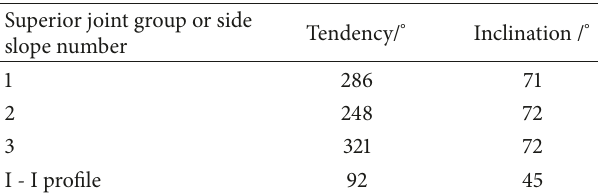
Table 1: Characteristics of structural planes within the study